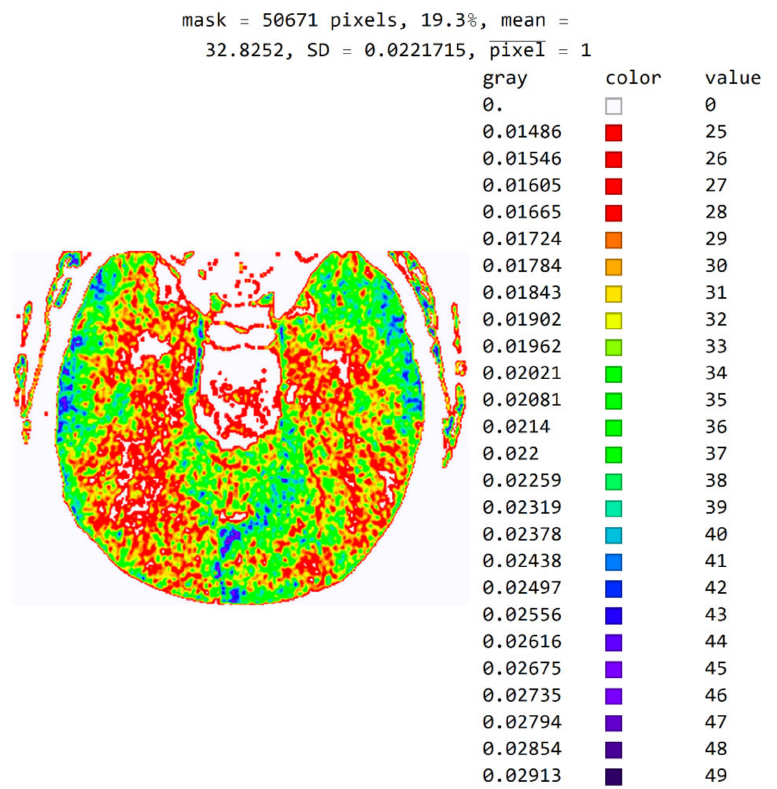
Figure 11. Image with the exact values of an integer type on the color map of the visible spectrum from pixel values 25 to 49. All other pixels outside this range have a value of 0 and are displayed in